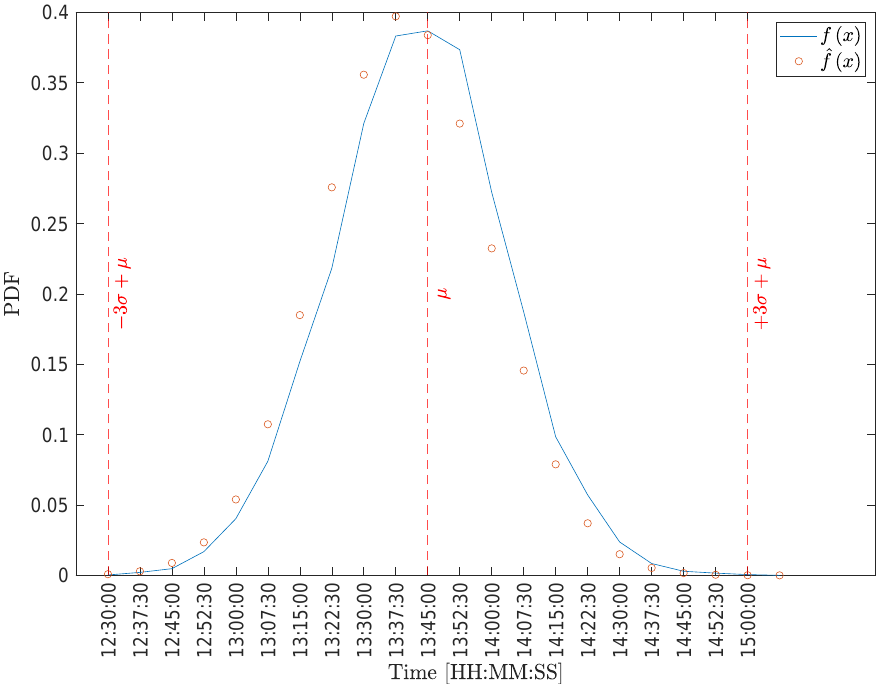
Figure 7. PDF f ( x ) and estimator PDF ˆ f k for the interval from 12:30 to 15:00. The verification for starting individual SAs was repeated for a different time range. Again, it was assumed that σ would correspond to 13:45. The range ± 3 σ was changed this time. The time range during which SAs could be run was reduced. The range is from − 3 σ = 12: 30 to + 3 σ = 14:00. Figure 8 shows a histogram of the times obtained when SAs could be run.